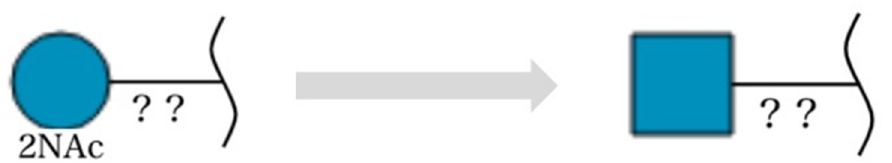
malized to the N-acetyl glucosamine symbol using the “Normalize”